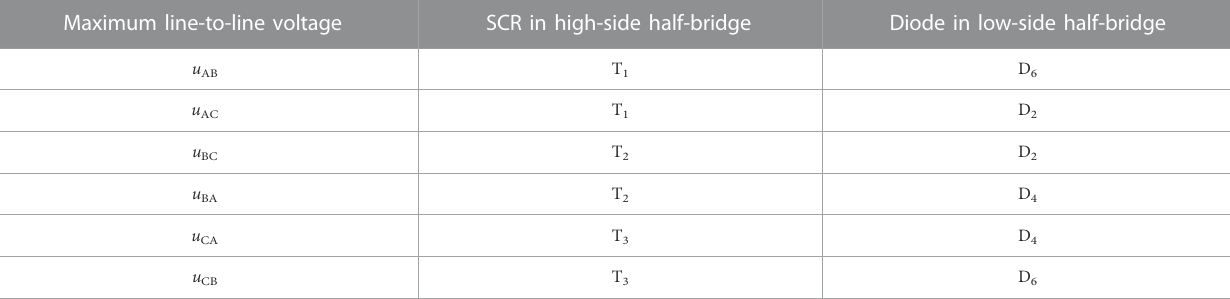
TABLE 1 Power electronic devices in on-state at different maximum line-to-line voltages during SCR control phase. Maximum line-to-line voltage SCR in high-side